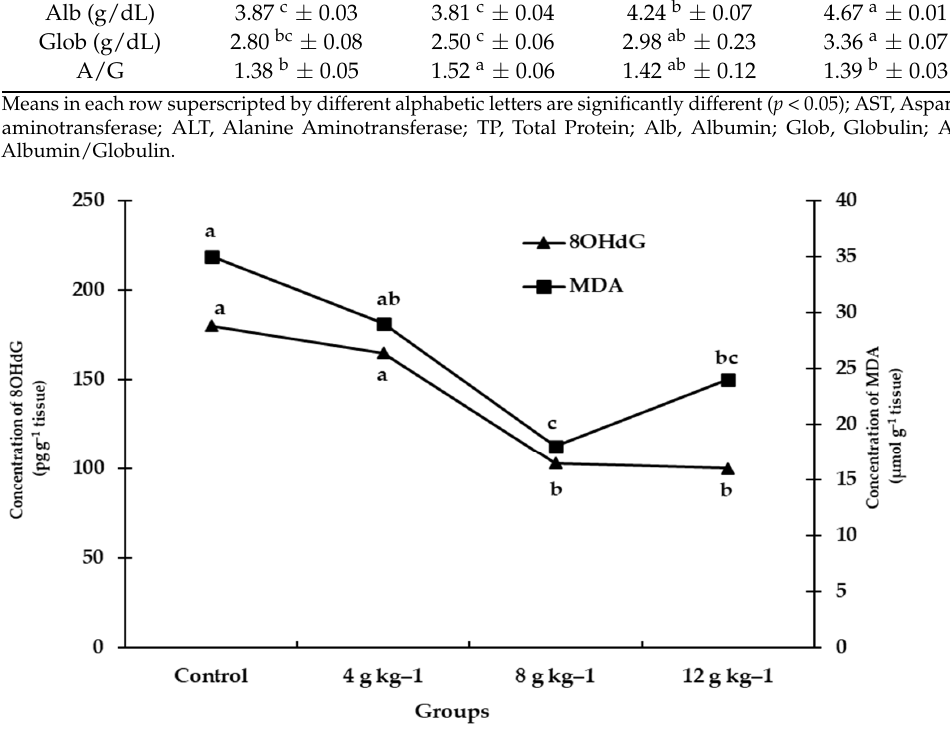
Figure 1. Effect of feeding on diets supplemented with different levels of S. marianum dry seeds, 0 (control), 4 g kg − 1 diet, 8 g kg − 1 diet, and 12 g kg − 1 diet during duck’s brooding period on liver MDA and 8OHdG parameters. a,b,c : there is no significant difference ( p > 0.05) between any two means that have the same superscripted letters within the same